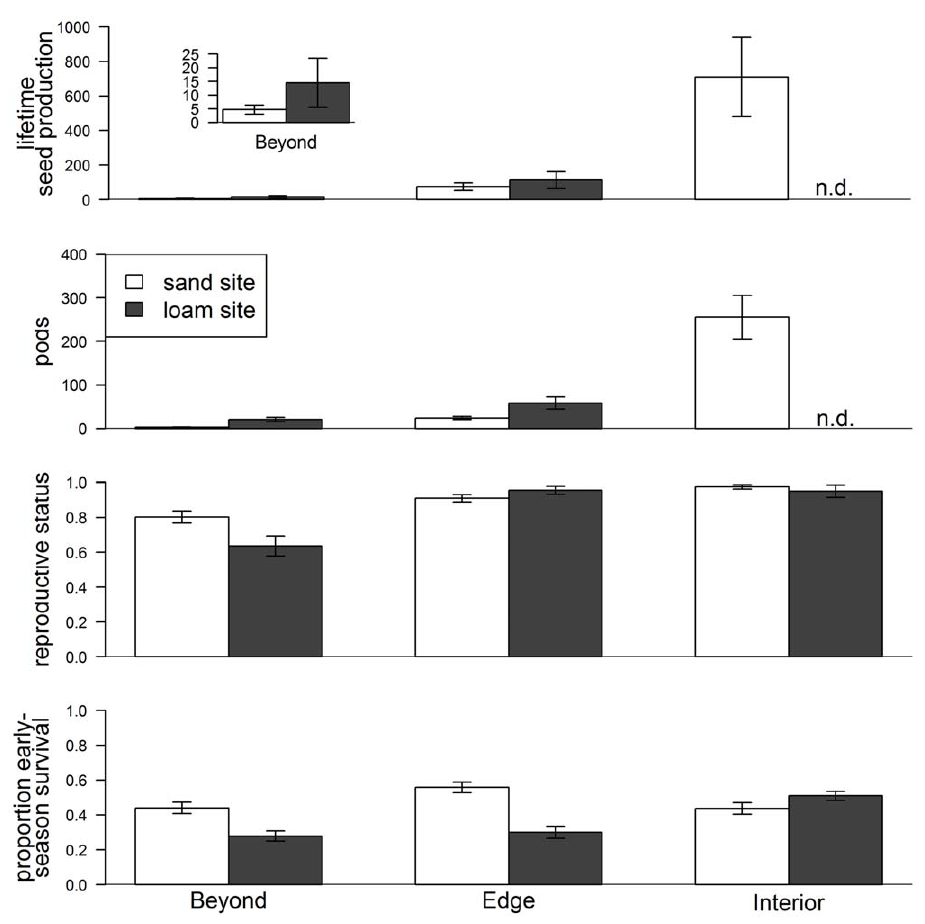
Figure 2. Maximum likelihood estimates of life history stages at each site in each region. Estimates from the best-fit aster model of proportion early-season survival, reproductive status (whether a plant reproduced or not) given survival, pods produced per plant given reproduction, and lifetime seed production, integrating across the previous stages. Bars represent standard errors. The inset plot shows lifetime seed production for the sites in the Beyond region. At the interior-loam site, the values for survival and reproductive status come from the observed data as all plants were destroyed before end of season data was collected (n.d.) so this site was not included in the aster analysis.